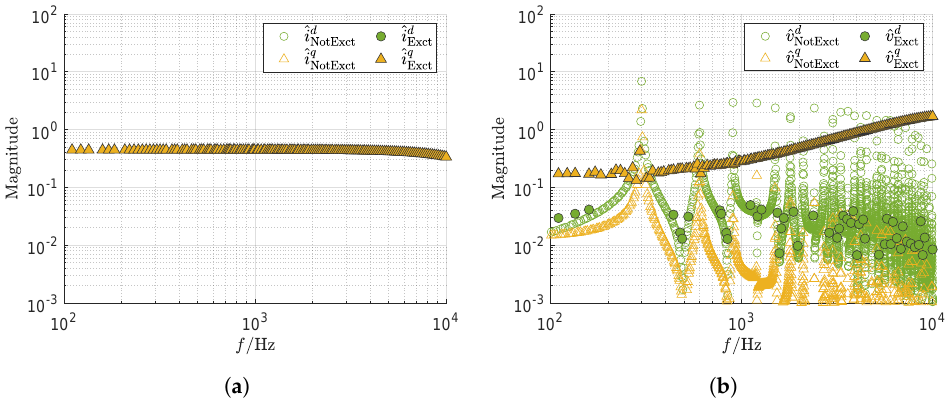
Figure 21. Compensated realistic impedance measurement scenario during excitation of the q -axis. ( a ) Spectrum of the current i meas in the dq domain. ( b ) Spectrum of the voltage v meas in the dq domain. Based on these measurements, the compensated non-parametric impedance Z g,CNP shown in Figure 22 can be calculated according to (14). In comparison with the uncompen- sated non-parametric impedance Z g,NP shown in Figure 17, the much lower proportion of outliers in the coupling terms is noticeable.